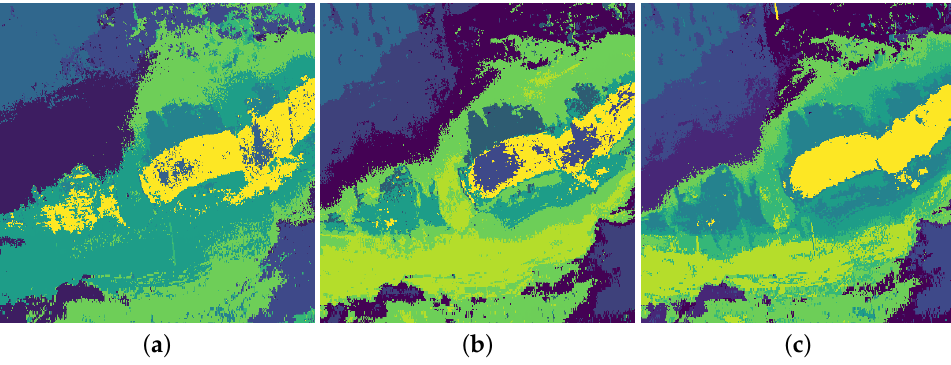
Figure 2. Examples of produced spectral cluster maps with a predefined number of 10 clusters from the FRT0001c71b dataset. ( a ) Autoencoder + GMM; ( b ) PCA + K-Means; ( c ) UMAP +